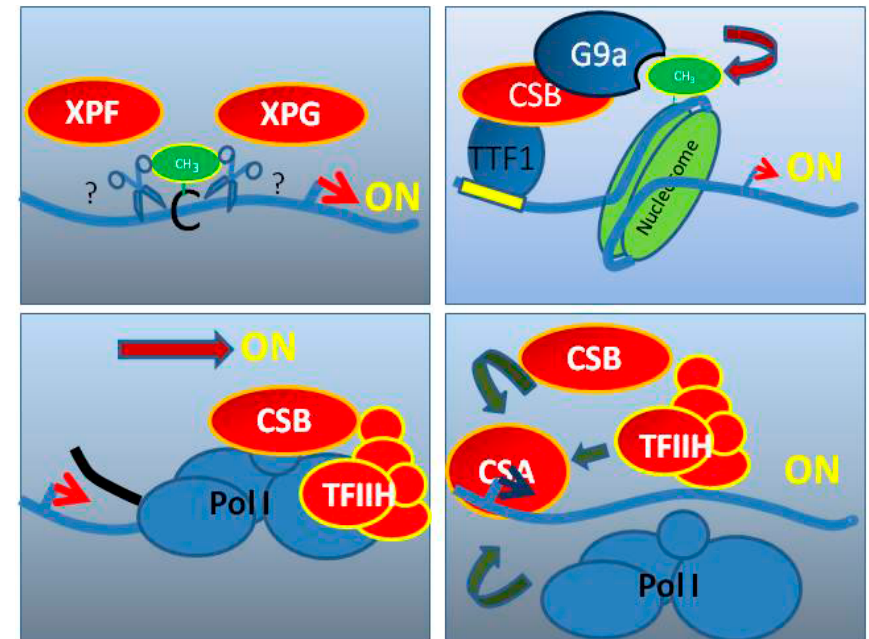
Figure 1. Graphical representation of the presumed/shown functions of the Cockayne syndrome proteins ( red ) in RNA polymerase I transcription. The functions are ( from upper left ), de-methylation of the promoter, attraction of a histone-modifier, reinitiation of basal transcription, and stimulation of elongation.